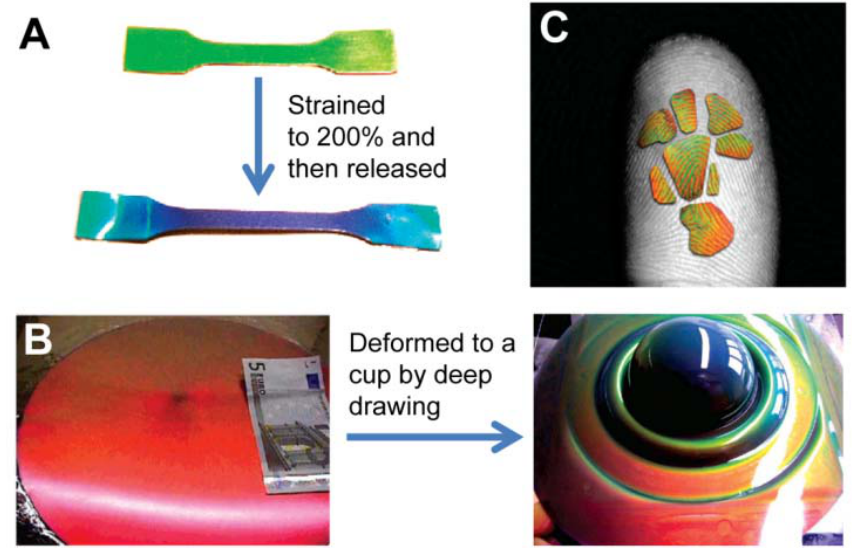
Figure 13. ( A ) Deformation of rubbery PC films obtained from polystyrene-poly(methyl methacrylate)-poly(ethyl acrylate) core-shell particles. Test bars before (green) and after (blue) 200% elongation of the PPC and release. ( B ) Elastomeric disk opal films prepared by compression molding before and after being deformed to a cup via deep drawing [63]. ( C ) A full-color fingerprint visualized using an elastic PC, overlayed onto a gray scale image of an index finger